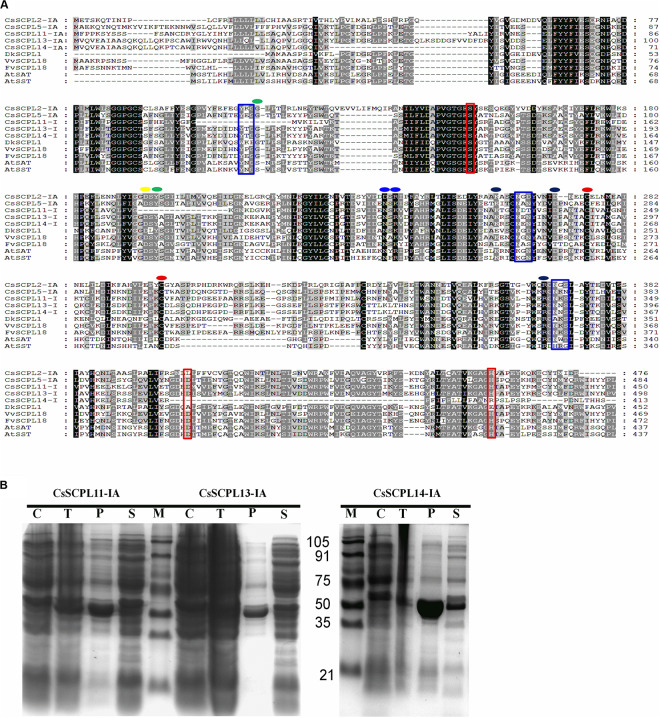
(A) Aligment of CsSCPL-I with characterized SCPLs from other species. Conserved amino acid residues participating in key roles are indicated: Cys residues that are likely to form the intersubunit disulphide bond (red circles), oxyanion hole (green circles), recognition of the sinapoyl moiety of the donor molecule (blue circles), the hydrogen bond network (yellow circle), the primary L-malate recognition (black circle), amino acid tracts corresponding to N-glycosylation sites (blue squares), and the amino acid residues forming the catalytic triad of serine carboxypeptidases (S, D, H) (red squares) (cf. Milkowski and Strack, 2004; Chiu et al., 2016). (B) The purified His-tagged CsSCPL11-IA (truncated), 13-IA (complete) and 14-IA (truncated) protein fusion recombinants expressed in E. coli and partially purified with nickel resin. Proteins were resolved on sodium dodecyl sulfate–polyacrylamide gel electrophoresis (SDS-PAGE), followed by Coomassie Blue R-250 staining.